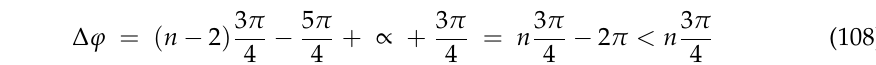
Figure 29. Vector displacement for the first two complex-conjugate roots for the case when 𝜔 𝜖 (0, ∞) .